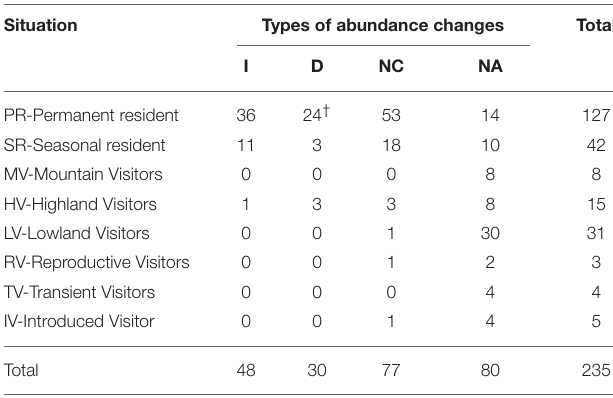
TABLE 4 | Summary of abundance changes of bird species due to the different factors affecting them in the Sabana de Bogotá Audubon’s Christmas Bird Counts circle in 26 years